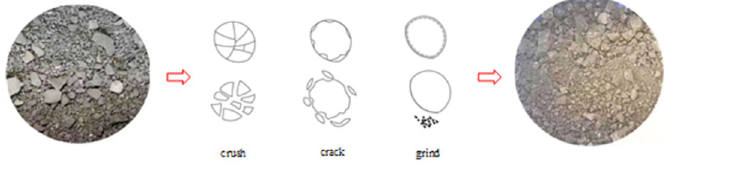
Fig 8. Coal particle crushing